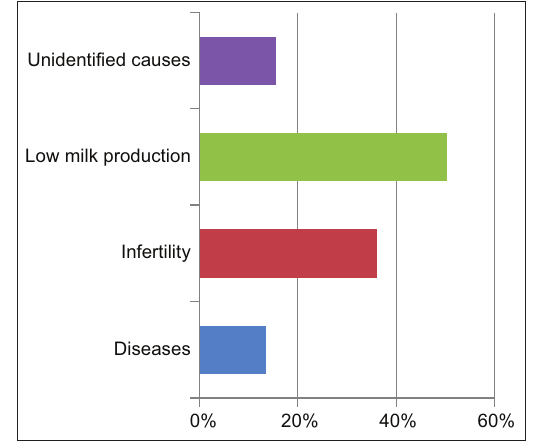
Figure-3: Major categories of culling causes of adult dairy cows over a 3‑year period (2016−2018) in a single intensively managed dairy farm in Jordan (n = 427).